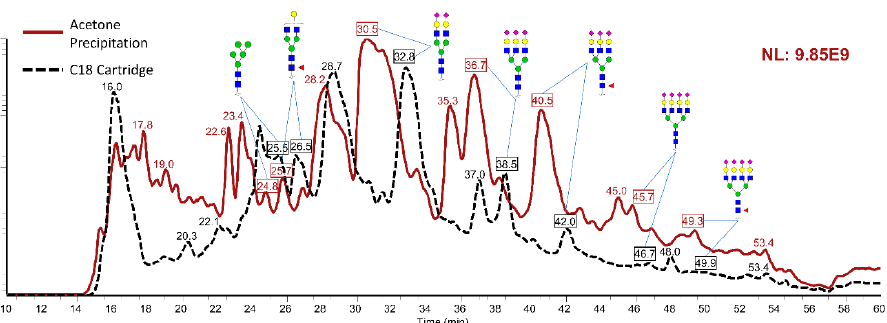
Figure 2. TICs of N -glycomics samples derived from 1 μ L of human serum after purified by using acetone (red trace) and C18 cartridges (black trace). Symbols of monosaccharides are the same as shown in Figure 1.